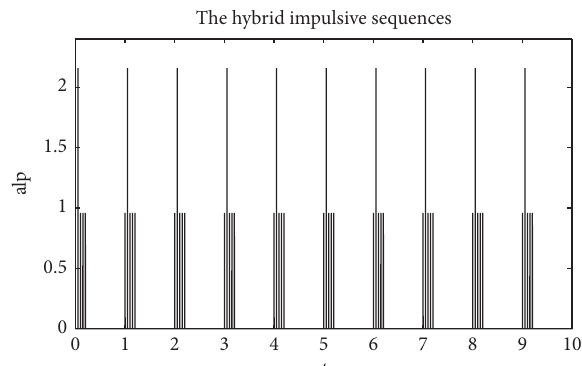
Figure 1: Thehybridimpulsivesequencewith T and α � 1 . 2.